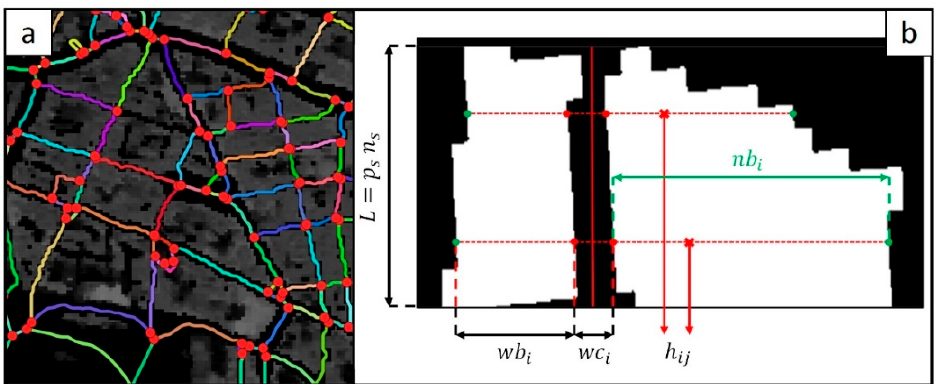
Figure 5. ( a ) An example of a VG obtained via the proposed automatic procedure, with arcs (various colors) and nodes (red points). ( b ) An example of a single canyon, after rotation, with its rectified axis (solid red line) and intersection points considered for the definition of the canyon parameters (red points) and building parameters (green points).